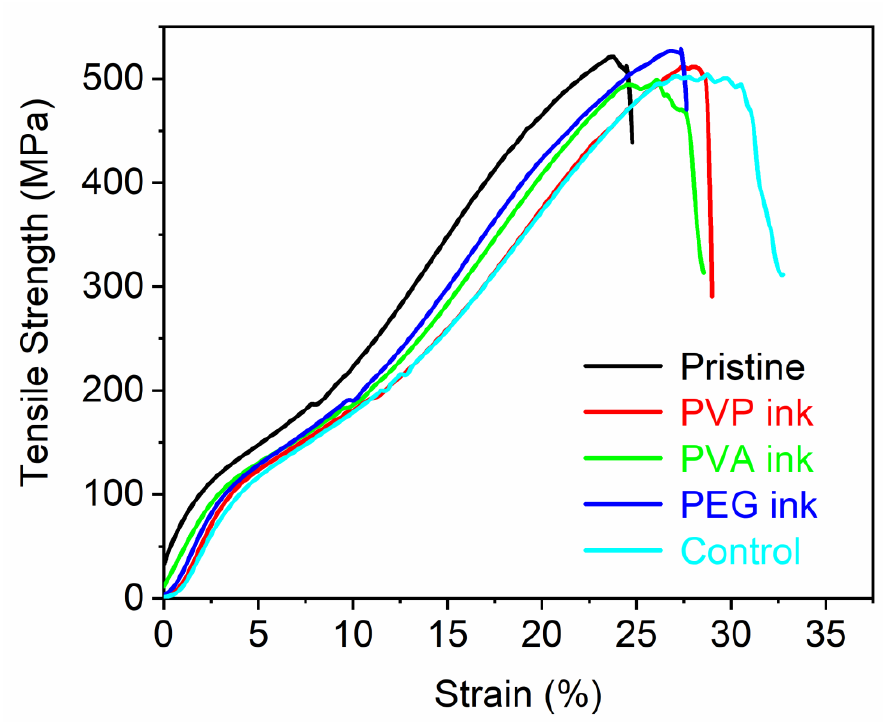
Figure 6. Quasi-static stress-displacement curves of yarns of pristine polyester fabric and fabric printed with PVP ink, PVA ink, PEG ink, and control sample. Table 7. Bending length of the pristine and printed